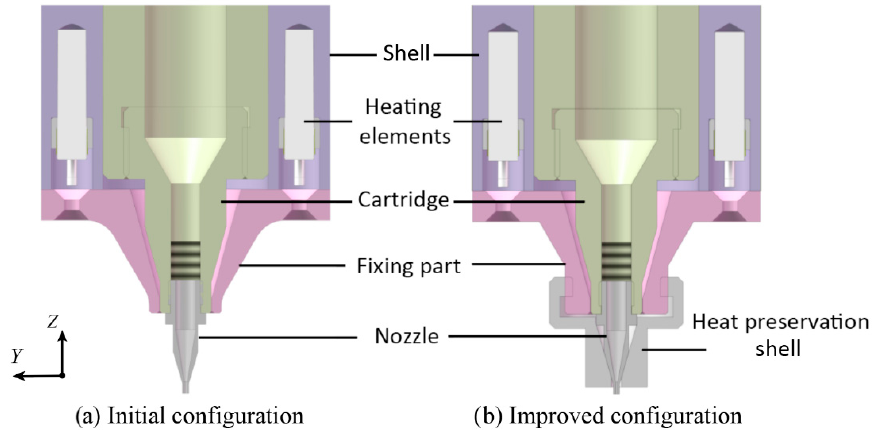
Figure 2. The initial and improved configurations of the homemade print head.